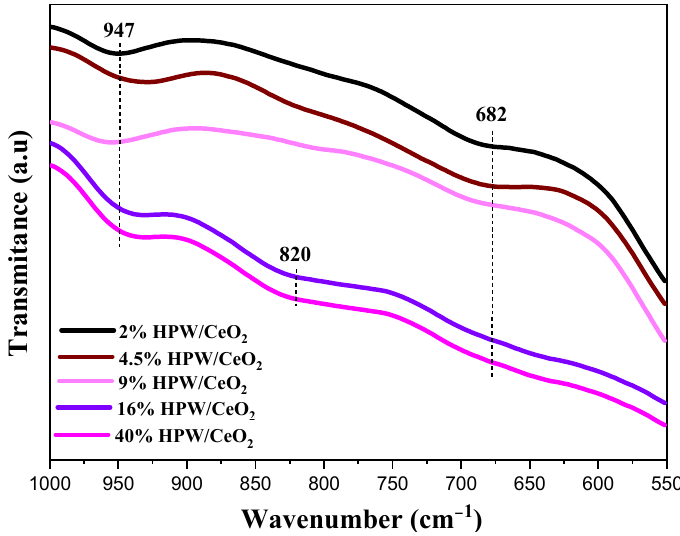
Figure 2. FT-IR spectra of CeO 2 , H 3 PW 12 O 40, and HPW/CeO 2 (2, 4.5, 9, 16, and 40 wt% W). H 3 PW 12 O 40 Raman spectrum (Figure 3a, lower spectrum) displays the Keggin skele- ton characteristic peaks ascribed to symmetric-asymmetric stretching modes of W I = O d (1011 cm − 1 ), W II = O d (994 cm − 1 ), P–O a (906 cm − 1 ), W-O b -W (522 cm − 1 ), and W-O c -W (237